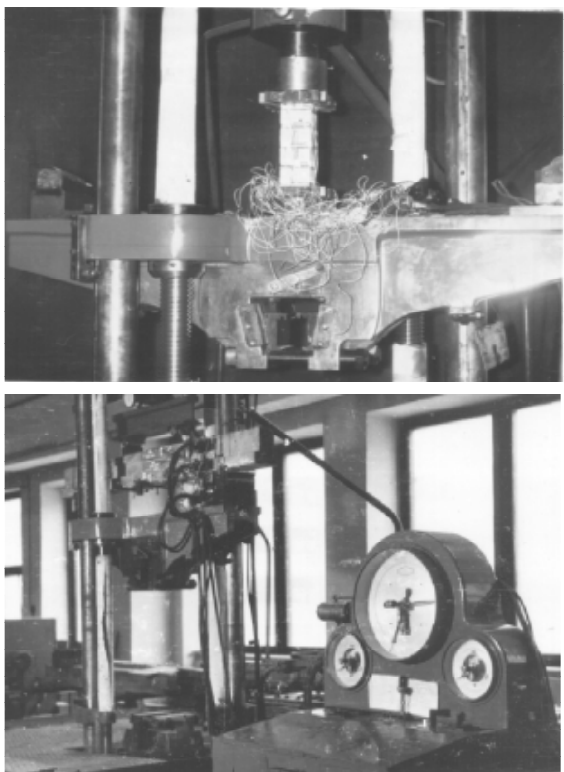
Table 1. Characteristics of the specimens Normal-cured Explanation